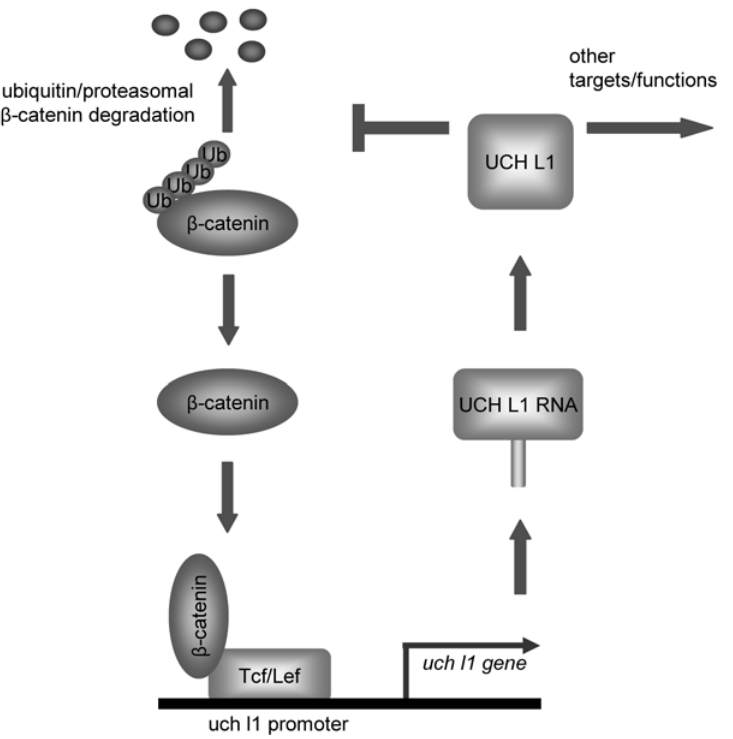
Figure 5. Working hypothesis: UCH L1 up-regulates its expression through b -catenin/TCF signaling. UCH L1 stabilizes b -catenin through deubiquitination and up-regulates b -catenin/TCF transcriptional activity. TCF4/Lef1 transcription factors directly bind to the uch l1 promoter and up- regulate UCH L1 RNA and protein expression.